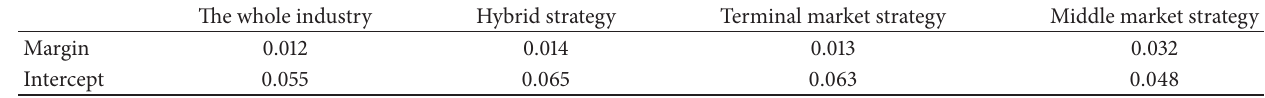
Table 9: Margin effects of working capital on performance in different strategies and in the whole industry.